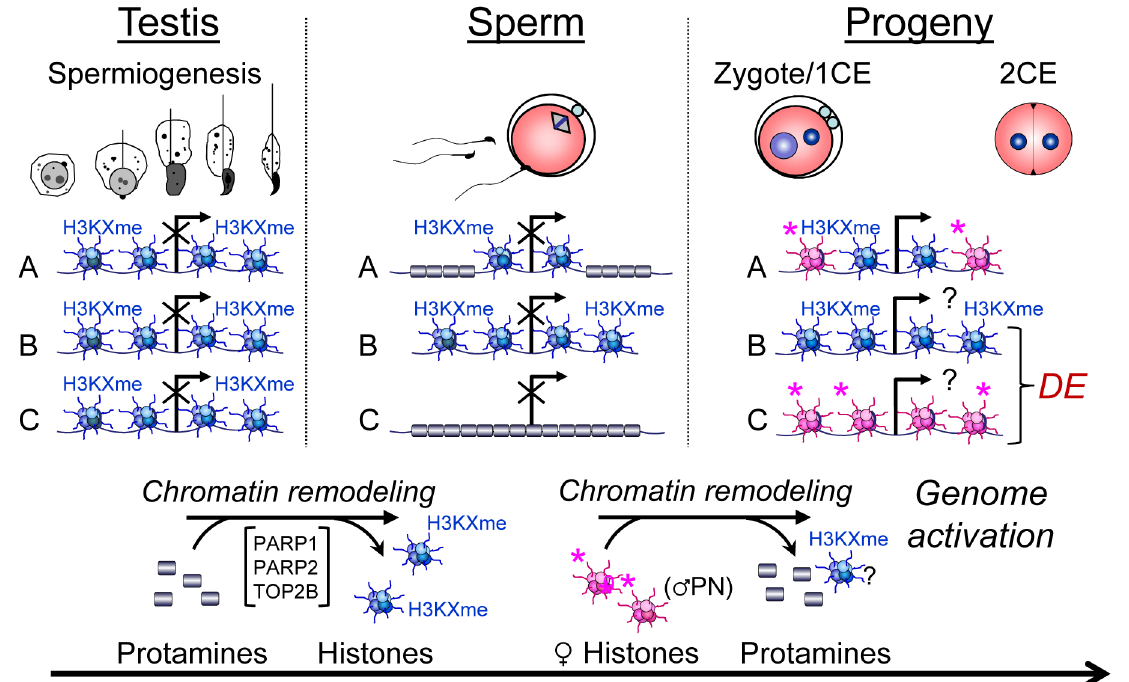
Figure 7. Chromatin remodeling events in spermiogenesis affect sperm histone-dependent regulation of gene expression during embryonic genome activation (working model). Chromatin remodeling during spermiogenesis (left panel) leads to the exchange of nucleosomes (blue) with their specific paternal tail modifications by protamines that normally leads to regulated retention of histones in certain domains of a given gene locus (A). Modulation of this remodeling process, for instance by altering PAR metabolism, results in either insufficient exchange of histones (B) or excessive remodeling causing more intense depletion of histones from that locus (C). As a result, histone association of this locus can be variable in sperm (middle panel). After fertilization, the paternal chromatin becomes rapidly remodeled, again with the exchange of protamines, but presumably not paternal histones, for maternally provided histones (pink) with maternal tail modifications that are mostly activating or nondescript in nature (right hand panel). As a result, the ratio of maternal and paternal histones can vary at the time point of genome activation, leading to continued differential epigenetic remodeling of the locus and ensuing differential expression (DE) in the early embryo.